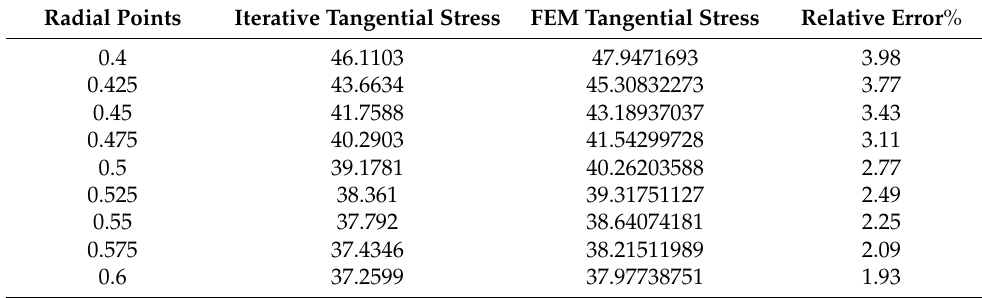
Table 3. Comparison of tangential stress in FGM cylinder using iterative technique and FEM under internal pressure, P a = 50 MPa and external pressure, P b = 20